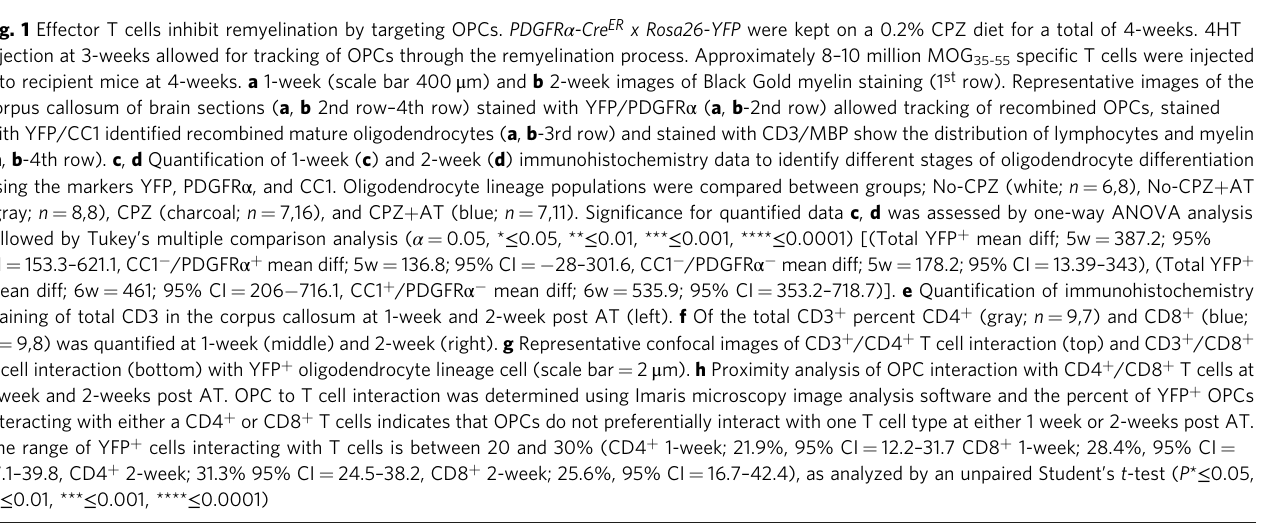
Fig. 1 Effector T cells inhibit remyelination by targeting OPCs. PDGFR α -Cre ER x Rosa26-YFP were kept on a 0.2% CPZ diet for a total of 4-weeks. 4HT injection at 3-weeks allowed for tracking of OPCs through the remyelination process. Approximately 8 – 10 million MOG 35-55 speci fi c T cells were injected into recipient mice at 4-weeks. a 1-week (scale bar 400 μ m) and b 2-week images of Black Gold myelin staining (1 st row). Representative images of the corpus callosum of brain sections ( a , b 2nd row – 4th row) stained with YFP/PDGFR α ( a , b -2nd row) allowed tracking of recombined OPCs, stained with YFP/CC1 identi fi ed recombined mature oligodendrocytes ( a , b -3rd row) and stained with CD3/MBP show the distribution of lymphocytes and myelin ( a , b -4th row). c , d Quanti fi cation of 1-week ( c ) and 2-week ( d ) immunohistochemistry data to identify different stages of oligodendrocyte differentiation using the markers YFP, PDGFR α , and CC1. Oligodendrocyte lineage populations were compared between groups; No-CPZ (white; n = 6,8), No-CPZ + AT (gray; n = 8,8), CPZ (charcoal; n = 7,16), and CPZ + AT (blue; n = 7,11). Signi fi cance for quanti fi ed data c , d was assessed by one-way ANOVA analysis followed by Tukey ’ s multiple comparison analysis ( α = 0.05, * ≤ 0.05, ** ≤ 0.01, *** ≤ 0.001, **** ≤ 0.0001) [(Total YFP + mean diff; 5w = 387.2; 95% CI = 153.3 – 621.1, CC1 − /PDGFR α + mean diff; 5w = 136.8; 95% CI = − 28 – 301.6, CC1 − /PDGFR α − mean diff; 5w = 178.2; 95% CI = 13.39 – 343), (Total YFP + mean diff; 6w = 461; 95% CI = 206 − 716.1, CC1 + /PDGFR α − mean diff; 6w = 535.9; 95% CI = 353.2 – 718.7)]. e Quanti fi cation of immunohistochemistry staining of total CD3 in the corpus callosum at 1-week and 2-week post AT (left). f Of the total CD3 + percent CD4 + (gray; n = 9,7) and CD8 + (blue; n = 9,8) was quanti fi ed at 1-week (middle) and 2-week (right). g Representative confocal images of CD3 + /CD4 + T cell interaction (top) and CD3 + /CD8 + T cell interaction (bottom) with YFP + oligodendrocyte lineage cell (scale bar = 2 μ m). h Proximity analysis of OPC interaction with CD4 + /CD8 + T cells at 1 week and 2-weeks post AT. OPC to T cell interaction was determined using Imaris microscopy image analysis software and the percent of YFP + OPCs interacting with either a CD4 + or CD8 + T cells indicates that OPCs do not preferentially interact with one T cell type at either 1 week or 2-weeks post AT. The range of YFP + cells interacting with T cells is between 20 and 30% (CD4 + 1-week; 21.9%, 95% CI = 12.2 – 31.7 CD8 + 1-week; 28.4%, 95% CI = 17.1 – 39.8, CD4 + 2-week; 31.3% 95% CI = 24.5 – 38.2, CD8 + 2-week; 25.6%, 95% CI = 16.7 – 42.4), as analyzed by an unpaired Student ’ s t -test ( P * ≤